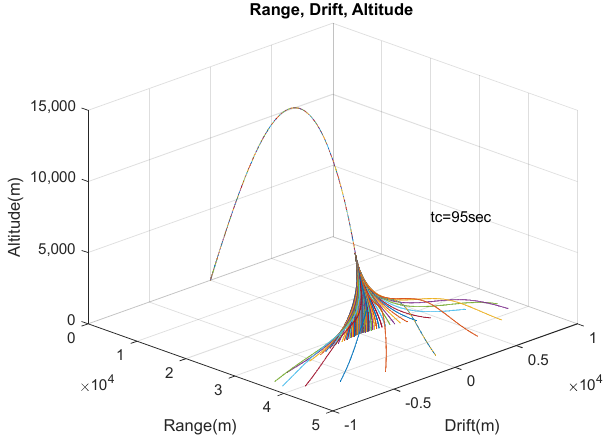
Figure 9. Control Activated at 95 s.